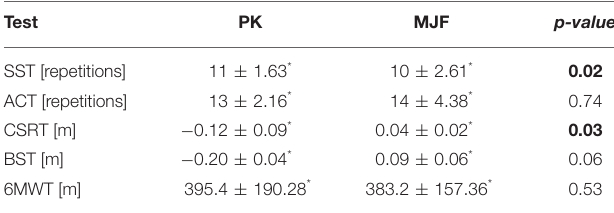
TABLE 2 | Force data obtained from the lower limb strength of the participants. TABLE 3 | Senior Fitness Test (SFT)